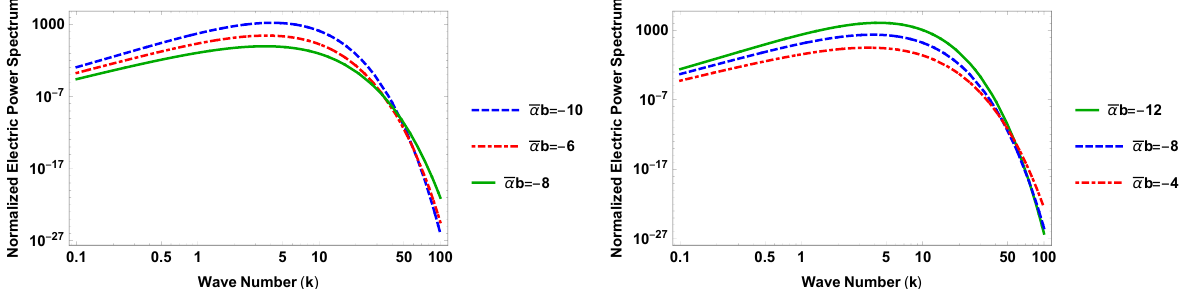
Figure 1. Scale dependance of the magnetic power spectrum has been demonstrated. The figure on the left demonstrates normalized magnetic power spectrum for negative values of ν , while that on the right demonstrates the same for positive choices of ν . As evident, for smaller values of | ¯ α b | the scale dependance of the power spectrum weaker. See, text for more discussion.